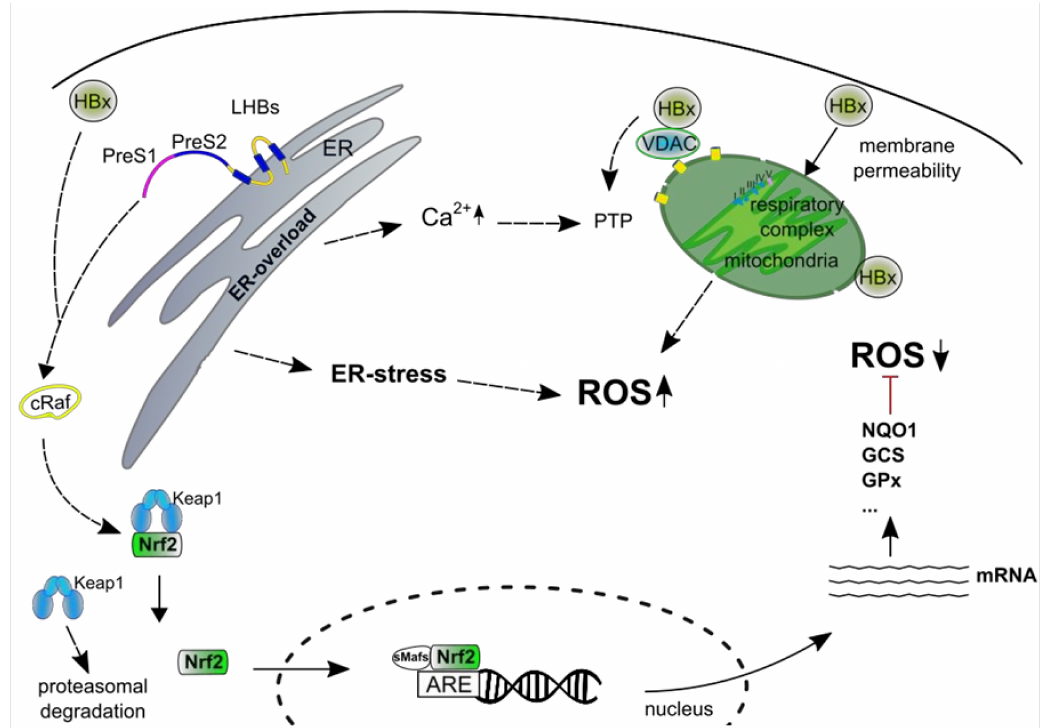
Figure 2. E ff ect of hepatitis B virus (HBV) on reactive oxygen species (ROS) production and inactivation. Dotted arrows describe indirect processes, solid lines describe translocations or direct e ff